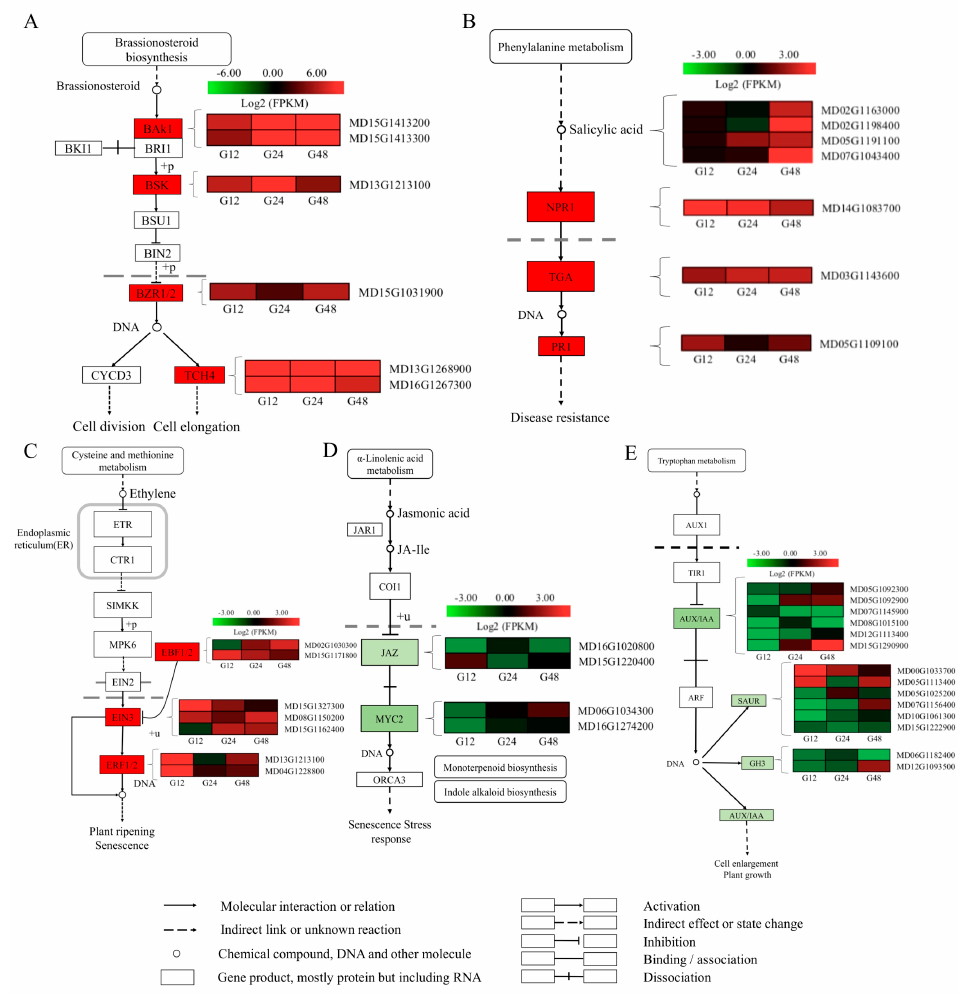
Figure 2. DEGs involved in phytohormone signaling transduction pathways. ( A ) Brassionsteroid (BR); ( B ) salicylic acid (SA); ( C ) ethylene (ET); ( D ) jasmonic acid (JA); ( E ) auxin (AUX). Expression values are presented as log 2FPKM value (red for upregulated, green for downregulated), and the vertical columns represent 12, 24 and 48 hpi from left to right.